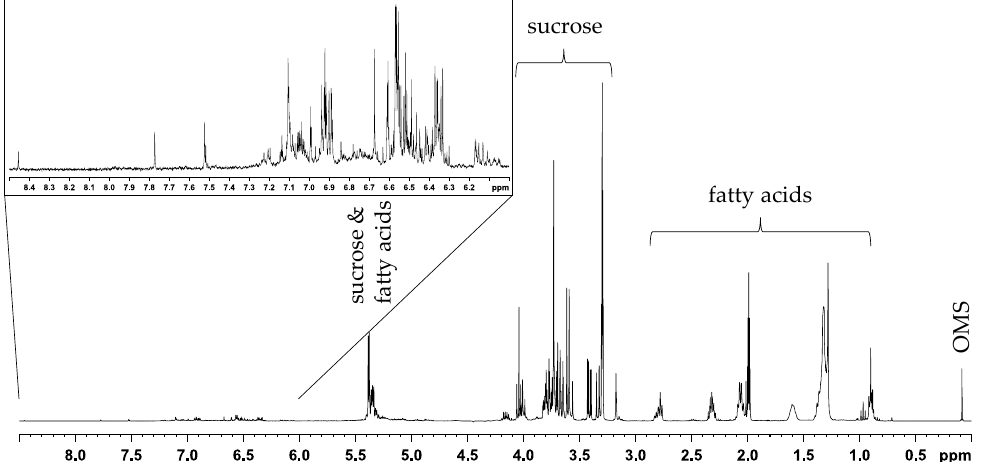
Figure 1. 1D 1 H NOESY spectrum (400 MHz) of walnut extract (acetonitrile- d 3 /methanol -d 4 , method A) showing signals from polar and non-polar compounds. The spectrum contains mainly signals from fatty acids. The region of carbohydrates is dominated by signals from sucrose. The region from 6.00 to 9.00 ppm is shown expanded.